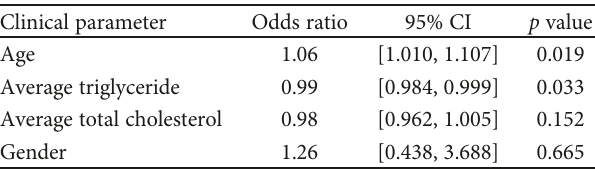
Table 5: Multiple logistic regression analysis of factors related with e ffi cacy of DPP-4 inhibitor in obese subjects with type 2 diabetes (BMI ≥ 25kg/m 2